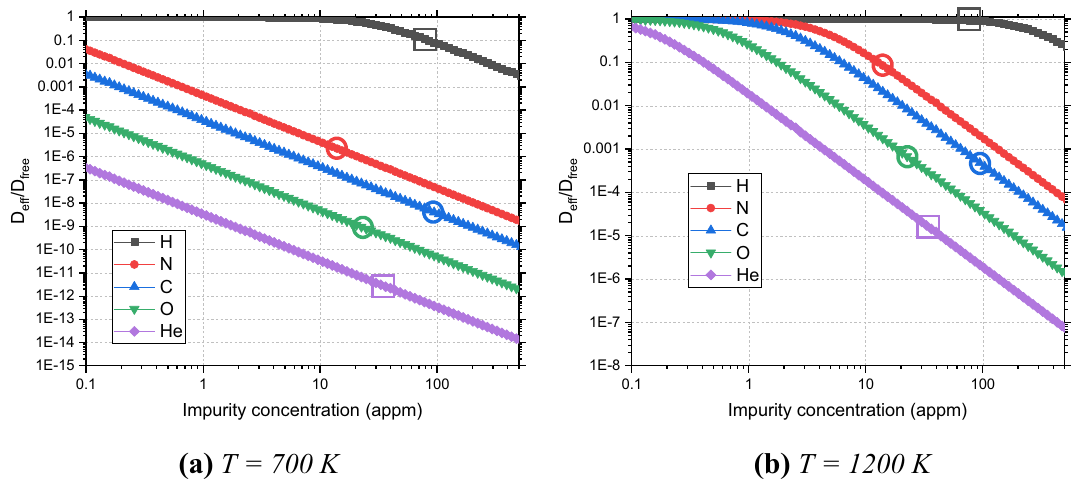
Figure 5. Relative change of diffusion coefficient D eff / D free of dislocation loops with 37 SIAs in the field of different impurities depending on their concentration at the temperature equal to ( a ) 700 K and ( b ) 1200 K. The circles show the typical concentration of the impurities in the as-received state if their initial typical concentration is non-zero. The squares show the expected production of H and He due to transmutation after 5 years of operation of plasma-facing W-made components in